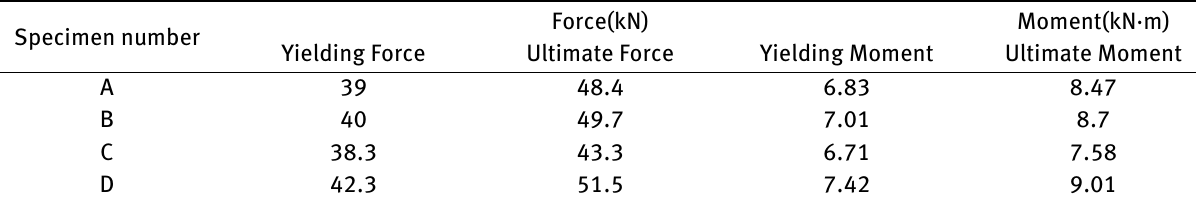
Table 4: Experimental results of beam test at 28 days